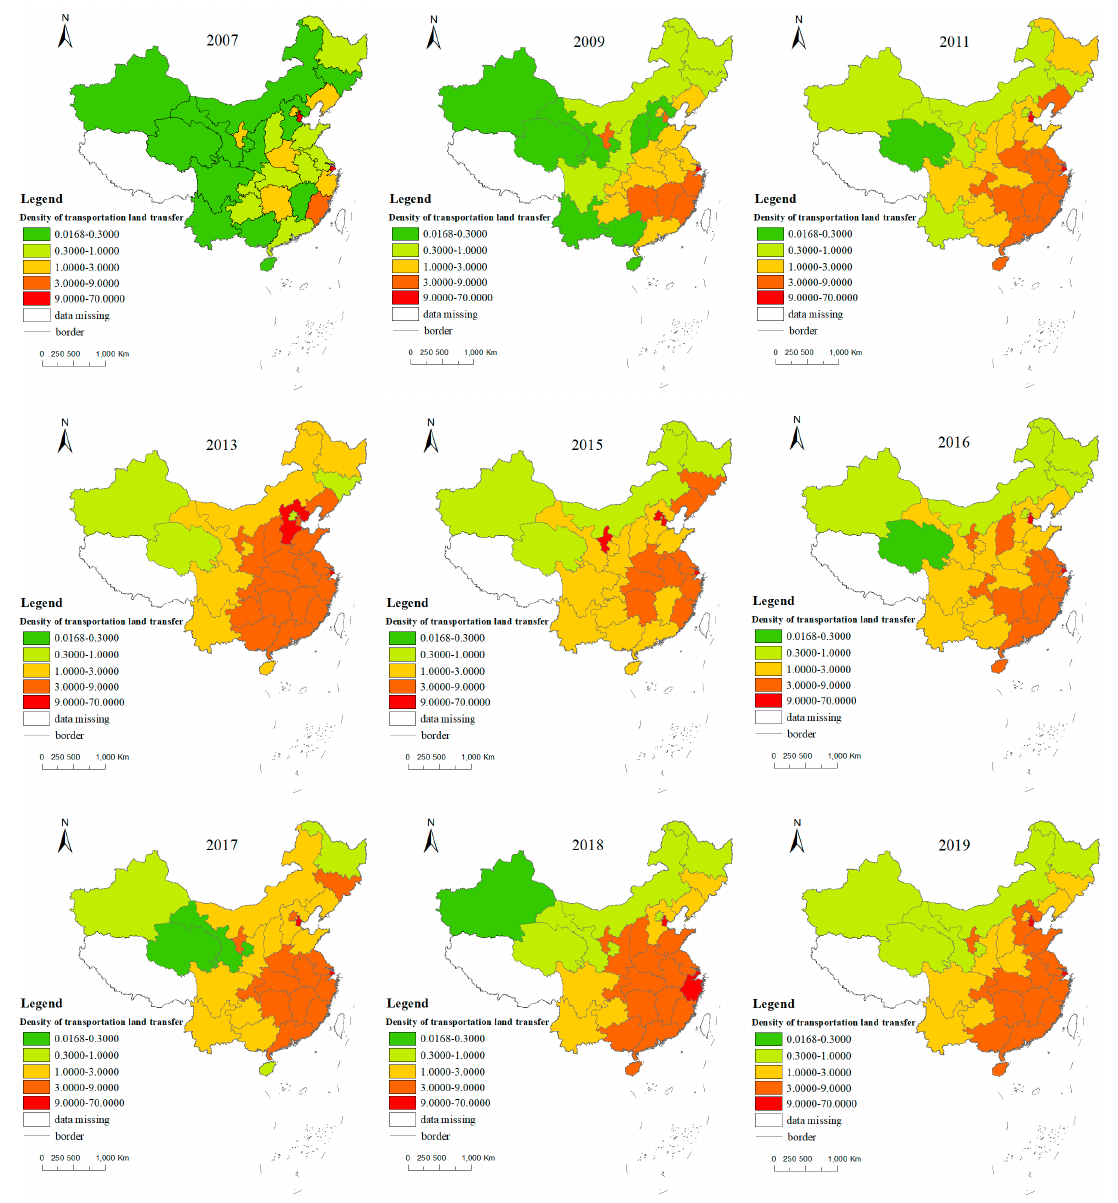
Figure 3. Spatial and temporal distribution and evolutionary trend of TLT density.